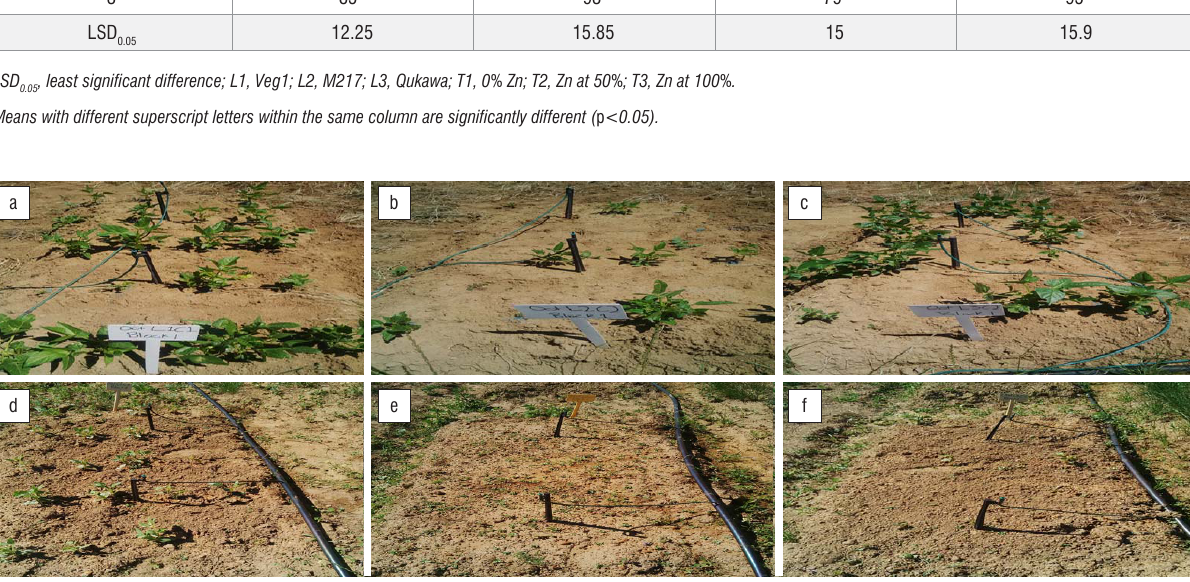
Figure 1: Photograph showing vegetative growth of the three cowpea lines (a,d) Veg1, (b,e) M217 and (c,f) Qukawa at (a–c) Bien Donne’ and (d–f) Nietvoorbj at 8 weeks after planting for the first planting date.